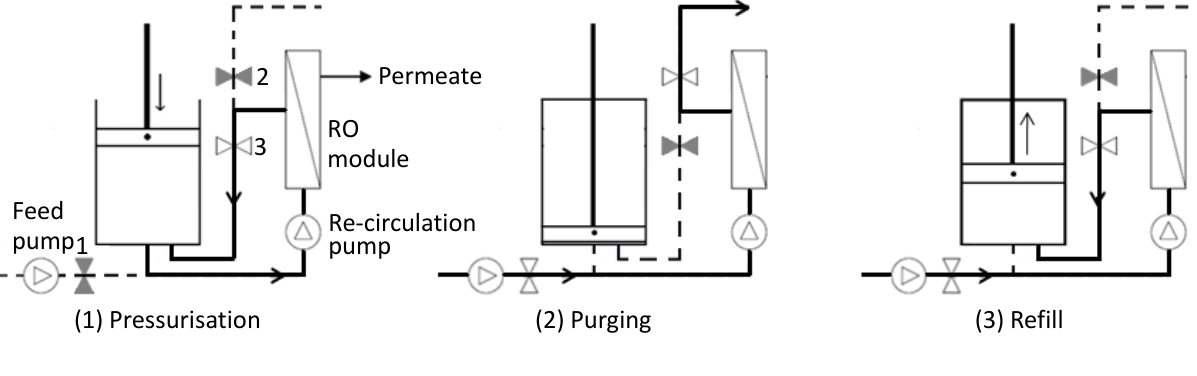
Figure 9. Three stages of the batch mode RO operation, from [27]. The solid array lines indicate the water flows and the dashed lines show the blocked water paths. The water flow is controlled by closing and opening the valves, which are represented as solid and hollow valve symbols,